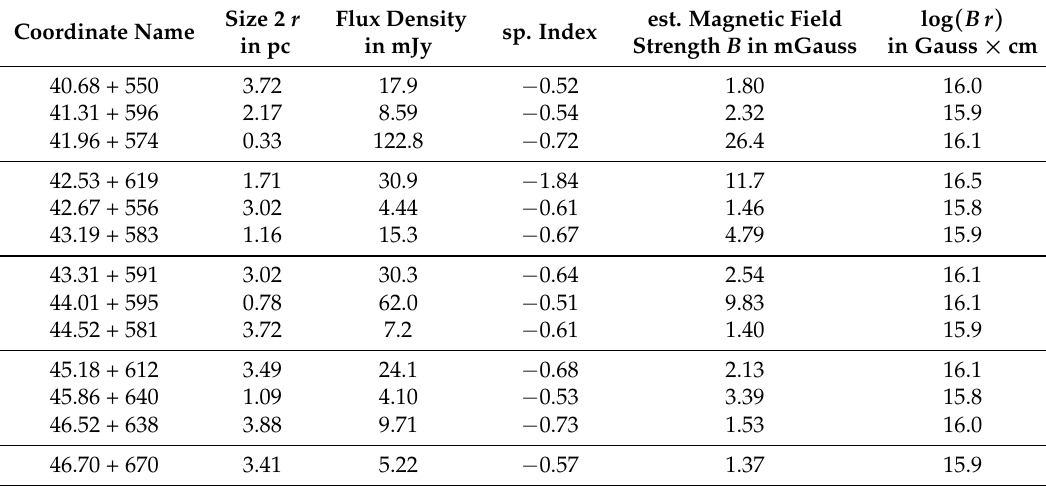
Table 1. Supernova remnants (SNRs) in starburst galaxy M82, based on Allen and Kronberg (their Table 5; 1998) [65], in turn based on Allen (1999)